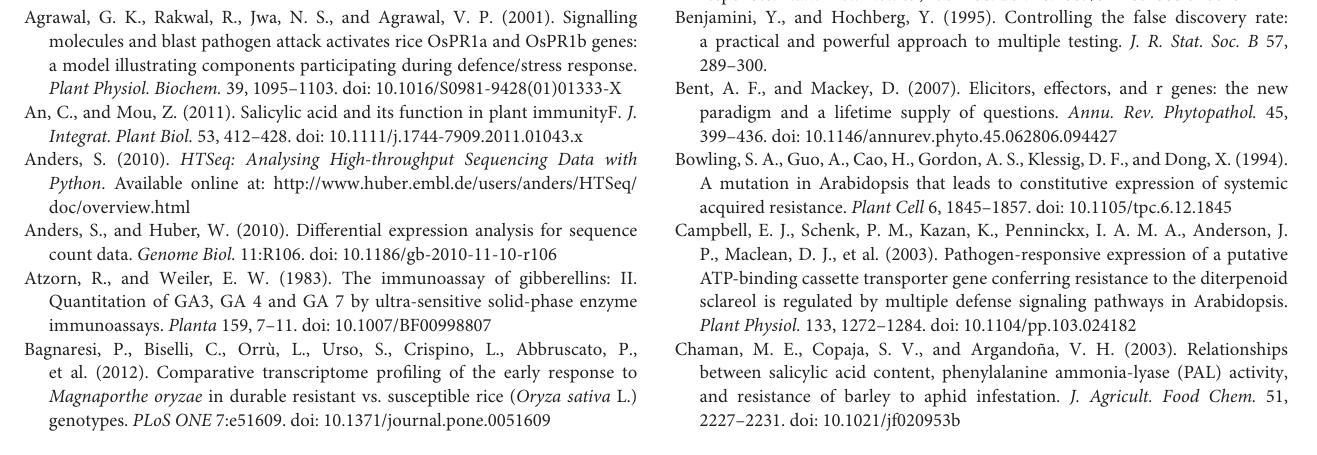
indicates the fold change in the gene expression levels in the different samples. The y-axis indicates the statistical significance of the gene expression differences. MoT1 vs. BuT1, MoT2 vs. BuT2, and MoT3 vs. BuT3 represent the comparison between the treatment and control rice groups after MoHrip1 treatment for 1, 2, and 3 days. Figure S6 | Venn diagrams of the groups. (A) Differentially expressed genes among the three groups of treated and control samples superimposed. (B,C) , numbers of differentially expressed genes in the treated and control samples compared with the non-treated samples. NoT1, MoT1, BuT1, MoT2, BuT2, MoT3, BuT3 represent the 0-day non-treatment group, the 1-day treatment group, the 1-day control group, the 2-day treatment group, the 2-day control group, the 3-day treatment group, and the 3-day control group, respectively. Figure S7 | Volcano plots show that the treated rice samples have more differentially expressed genes relative to the non-treated rice samples than the control rice samples. MoT1 vs. NoT0, MoT2 vs. NoT0, and MoT3 vs. NoT0, and MoT3vsNoT0 represent the comparisons between the treated rice and the non-treated rice after MoHrip1 treatment for 1, 2, and 3 days. BuT1 vs. NoT0, BuT2 vs. NoT0, and BuT3 vs. NoT0 represent the comparisons between the control and non-treated rice groups after treatment with protein buffer for 1, 2, and 3 days. Figure S8 | Root growth promotion of rice after treated with MoHrip1 or Tris-Cl. (A) Root growth promotion of rice plants. (B) Average length of rice plant root. MM (Rice immersed in MoHrip1 and sprayed with MoHrip1), M (Rice immersed in MoHrip1 and sprayed with Tris-Cl), and CK (Rice immersed in H 2 O and sprayed with Tris-Cl) were measured after 7 days inoculation with M. oryzae spores. Values are presented as the mean ± SD of three replicates, each consisting of 25 seedlings. Asterisks indicate statistically significant differences, as measured using SAS software (Duncan’s t test, ∗∗ p < 0.01, ∗ p < 0.05). Table S1 | Primer sequences used in this study. Table S2 | Statistics of the pathway enrichment of differentially expressed genes detected in treated rice after 1 day. A corrected p < 0.05 represents statistically significant enrichment of that pathway.